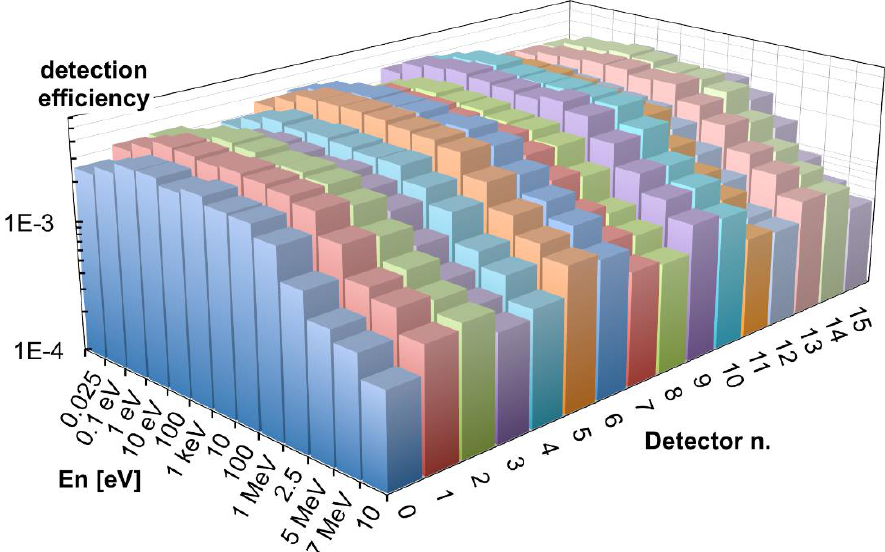
Figure 22. The simulated detection efficiency as a function of the impinging neutron energy for the 16 detectors in the 4 × 4 array configuration in the top position.